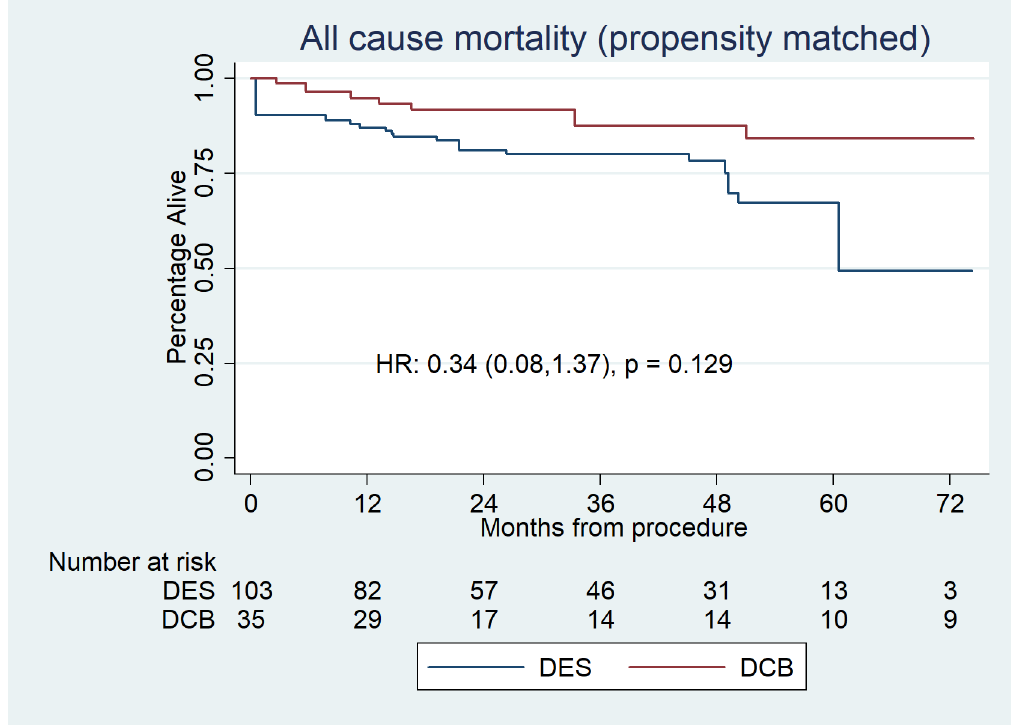
Figure 3. Propensity-matched Kaplan–Meier survival plot for all-cause mortality for DCBs versus DESs. This shows no significant difference between the groups. Cardiovascular mortality was 2 (4.9%) for the DCB group and 7 (6.5%) for the DES group (HR 1.21 [0.31–4.67], p = 0.786) (Figure 4), which was also non-significant after pro-